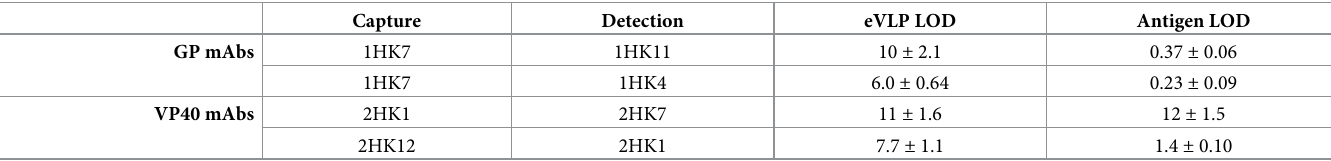
Table 3. Limit of detection (LOD) of optimized antigen-capture ELISA with Ebola virus-like particles (eVLPs) and purified GP and VP40 recombinant antigen (ng/ mL ±